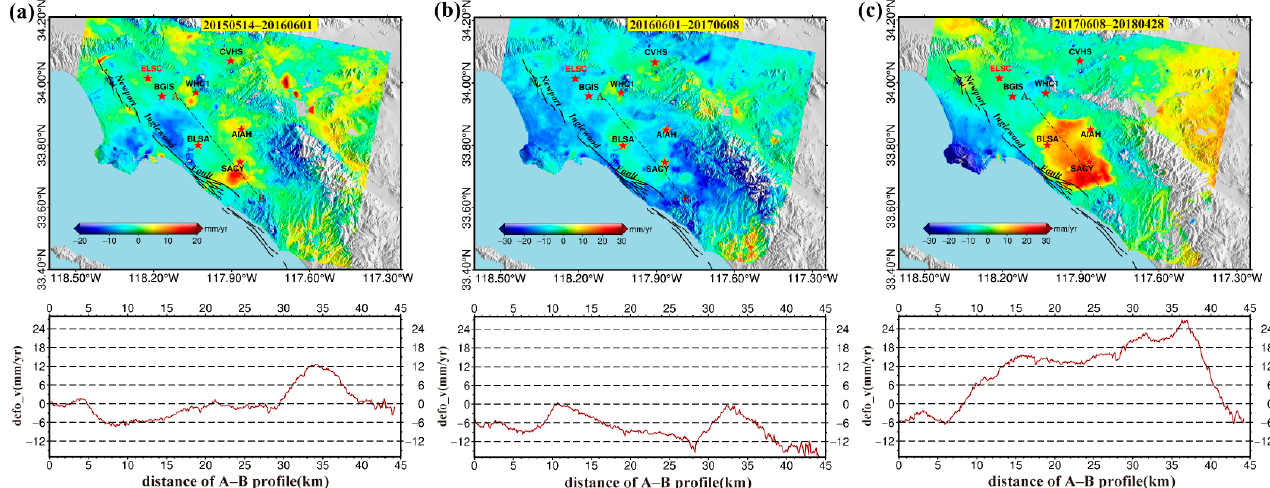
Figure 5. Mean LOS velocity maps over the Santa Ana basin for different years: ( a ) 20150514–20160601, secting obvious surface deformation. Red Pentagrams show the locations of the SCIGN GNSS sites for accuracy validation.